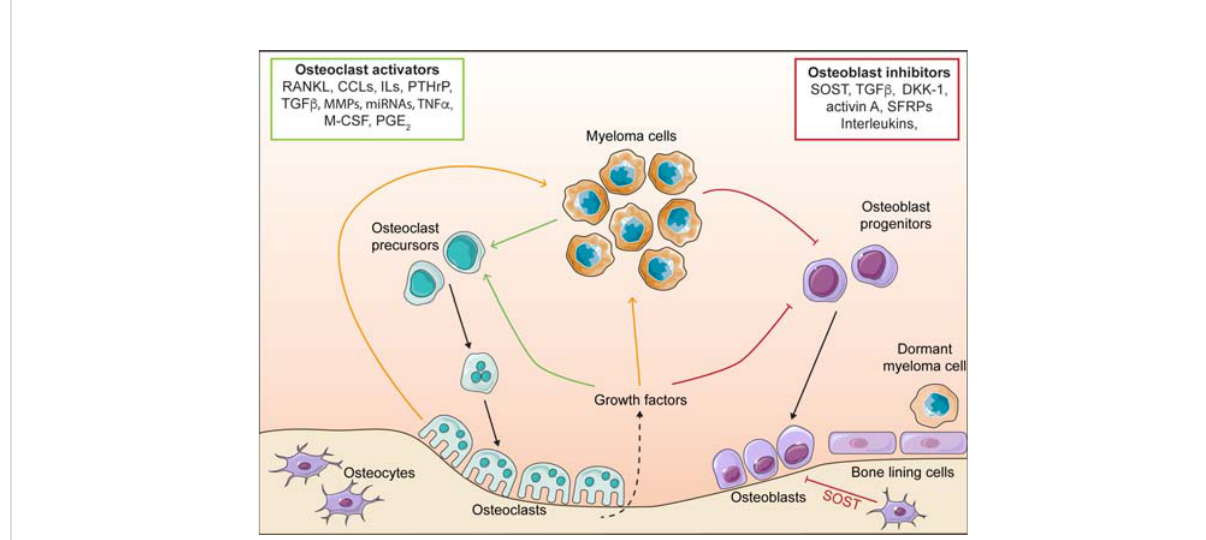
FIGURE 1 The vicious cycle in myeloma. Myeloma cells release osteoclast activating factors, which stimulate the formation of osteoclasts and increase bone resorption, leading to bone destruction. Myeloma cells also release osteoblast inhibitory factors that block osteoblast differentiation, and preventing bone formation. Osteoclasts release factors that stimulate myeloma growth. Elevated bone resorption leads to release of growth factors from the bone matrix (e.g. TGF b ) which further stimulate osteoclastogenesis and myeloma cell growth, whilst simultaneously inhibiting osteoblasts. Osteoblasts and bone lining cells promote myeloma dormancy. receptor activator of nuclear factor k -B (RANKL), CC chemokine ligands (CCLs), interleukins (IL), parathyroid hormone-related protein (PTHrP), matrix metalloproteinases (MMPs), tumour necrosis factor a